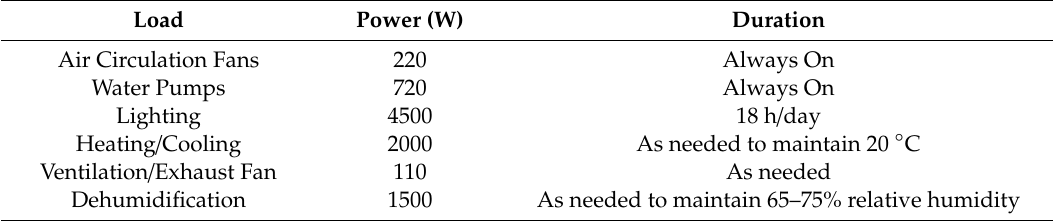
Table 1. Electric loads, capacity, and operation description of the container farm assumed for this study. Load Power (W) Duration Air Circulation Fans 220 Always On Water Pumps 720 Always On Lighting 4500 18 h / day Heating / Cooling 2000 As needed to maintain 20 ◦ C Ventilation / Exhaust Fan